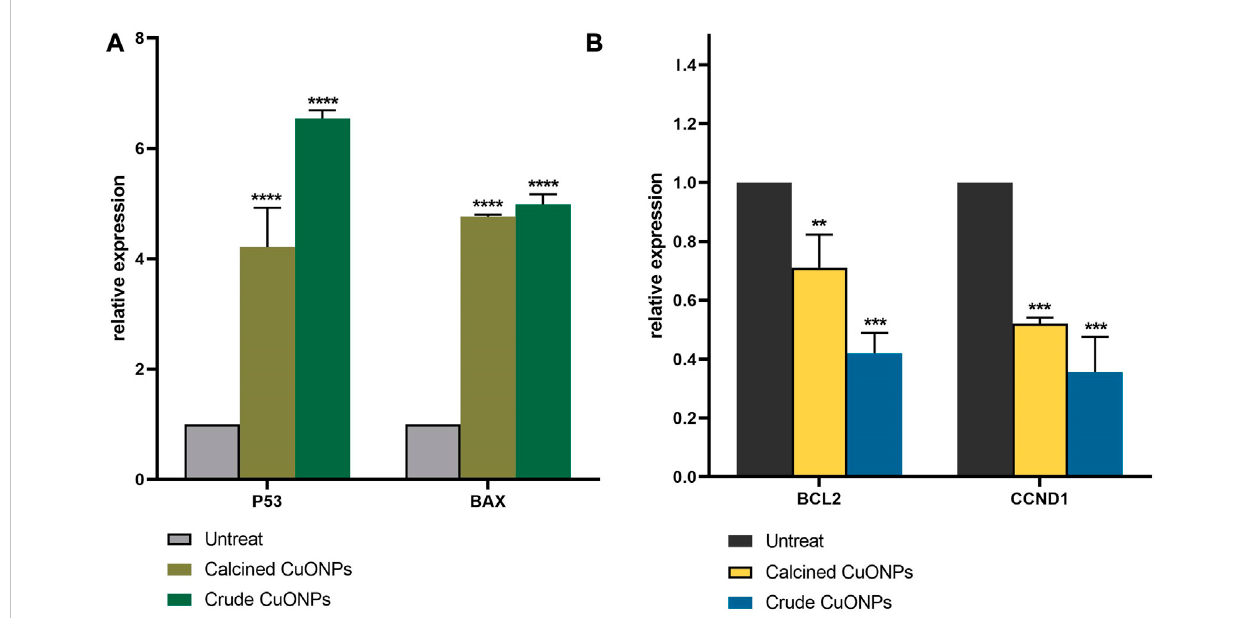
FIGURE 10 Analysis of gene expression by real-time PCR. The expression of P53 , BAX (A) , BCL2 and CCND1 (B) were normalized and plotted as relative fold change compared with the untreated cells. Data are represented as mean ± SD. ** p < 0.01, *** p < 0.001, **** p < 0.0001 indicate signi fi cant difference with untreated